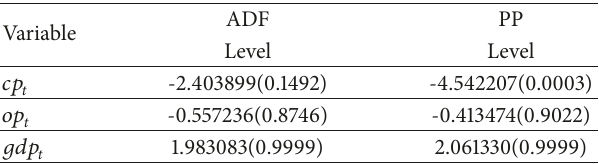
Table 1: Unit root test results of sequence level values.